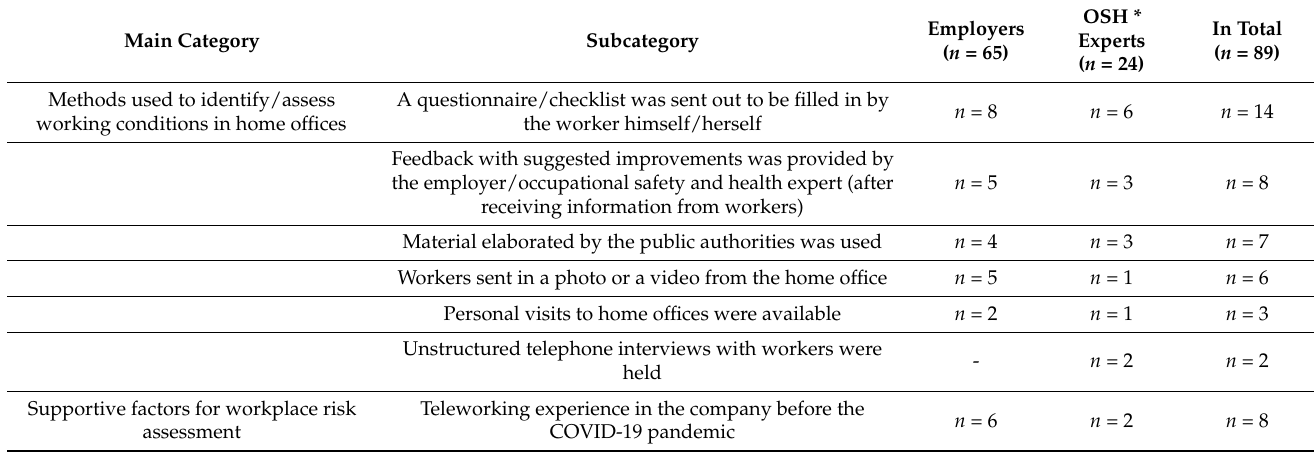
Table 1. Themes identified during research analysis ( n = number of persons for which theme was detected). Main